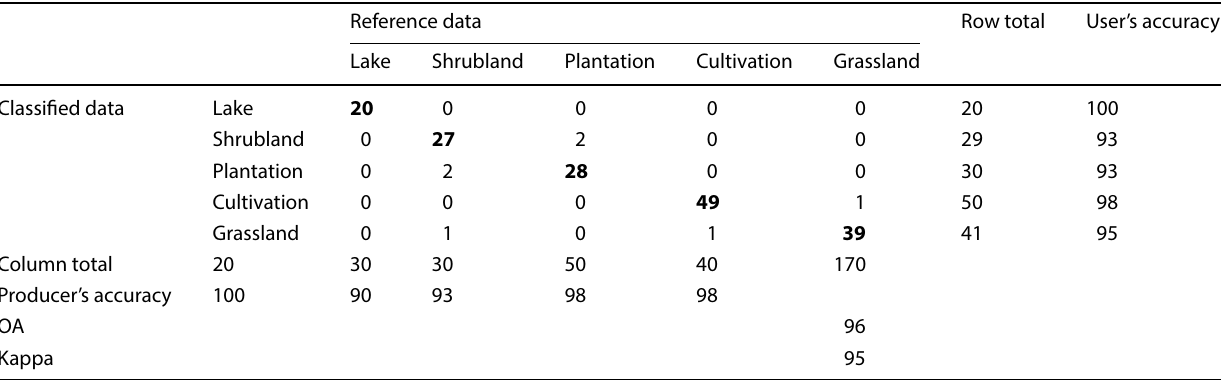
Table 4 Classification accuracy (2015)